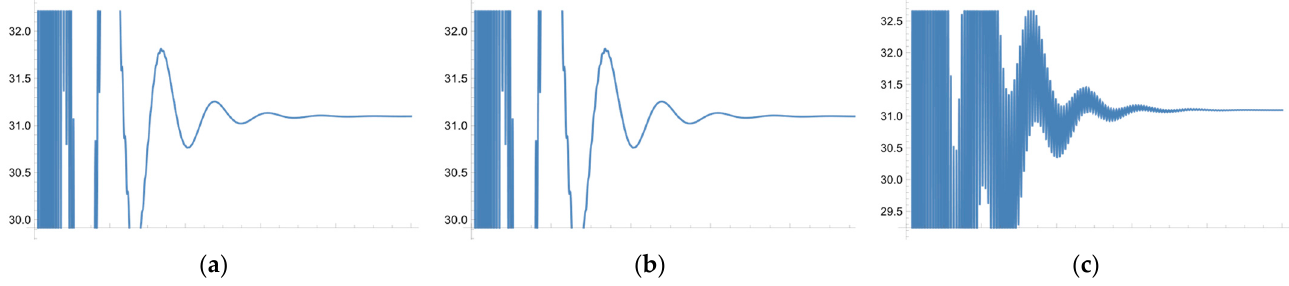
Figure 7. No. 10 state variable I ld 1 ( t ) solved from the 3 models. ( a ) Result from the proposed method, ( b ) Result from the original precise model. ( c ) Result from the traditional singular perturbation.